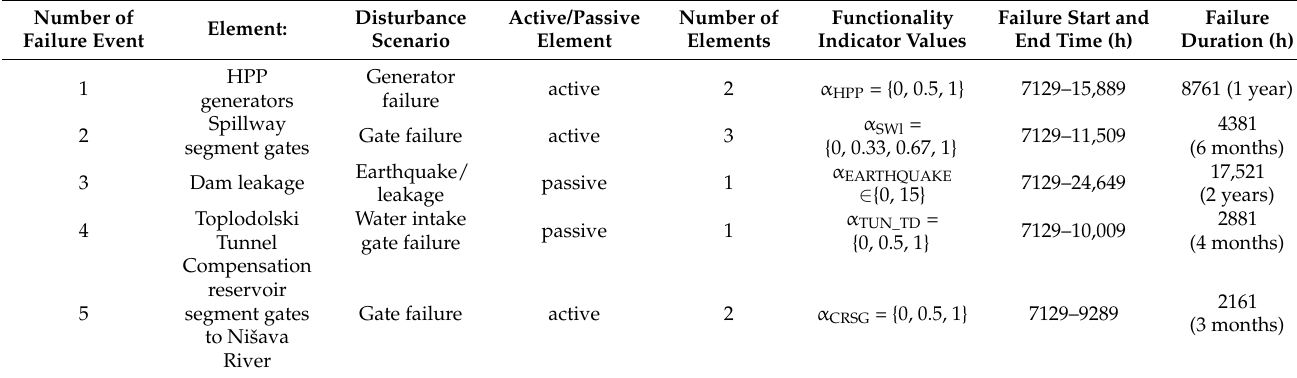
Table 3. Description of a single failure scenario event.